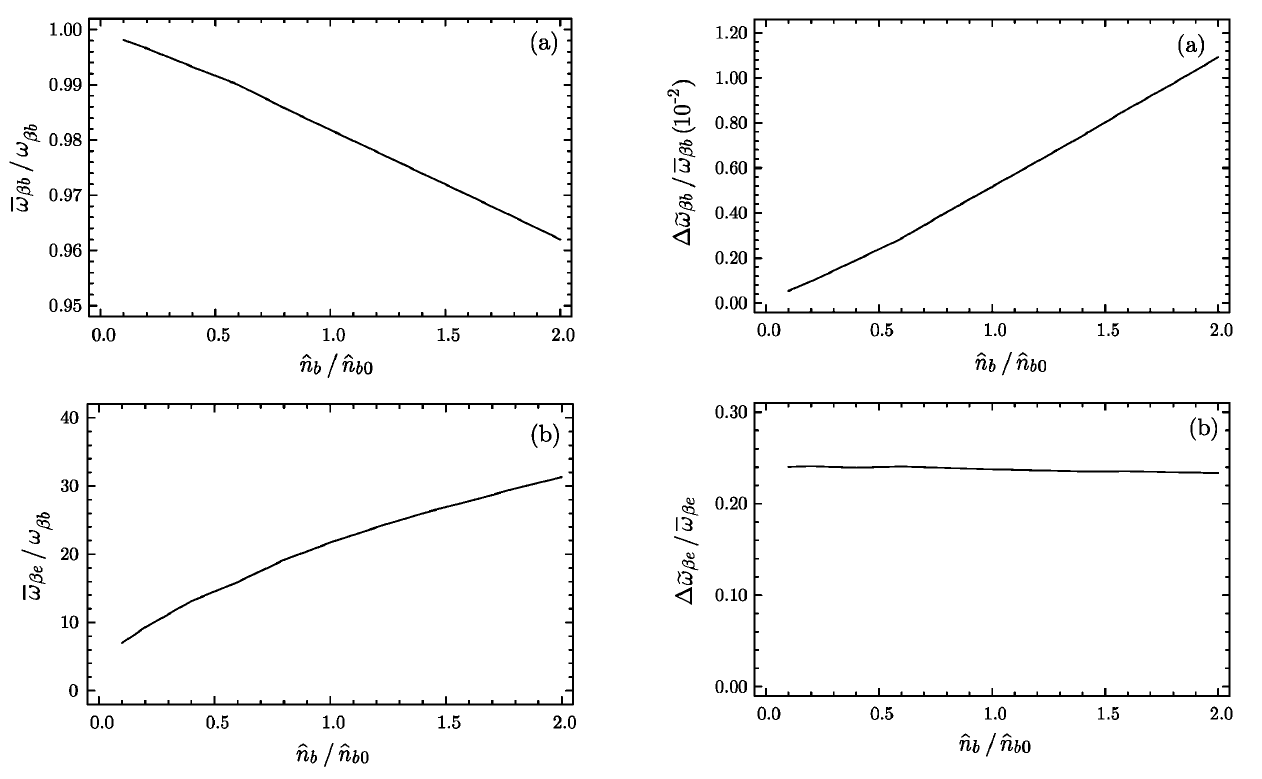
FIG. 8. Effective space-charge-induced frequency spread plotted verse normalized beam intensity for the (a) protons and (b)